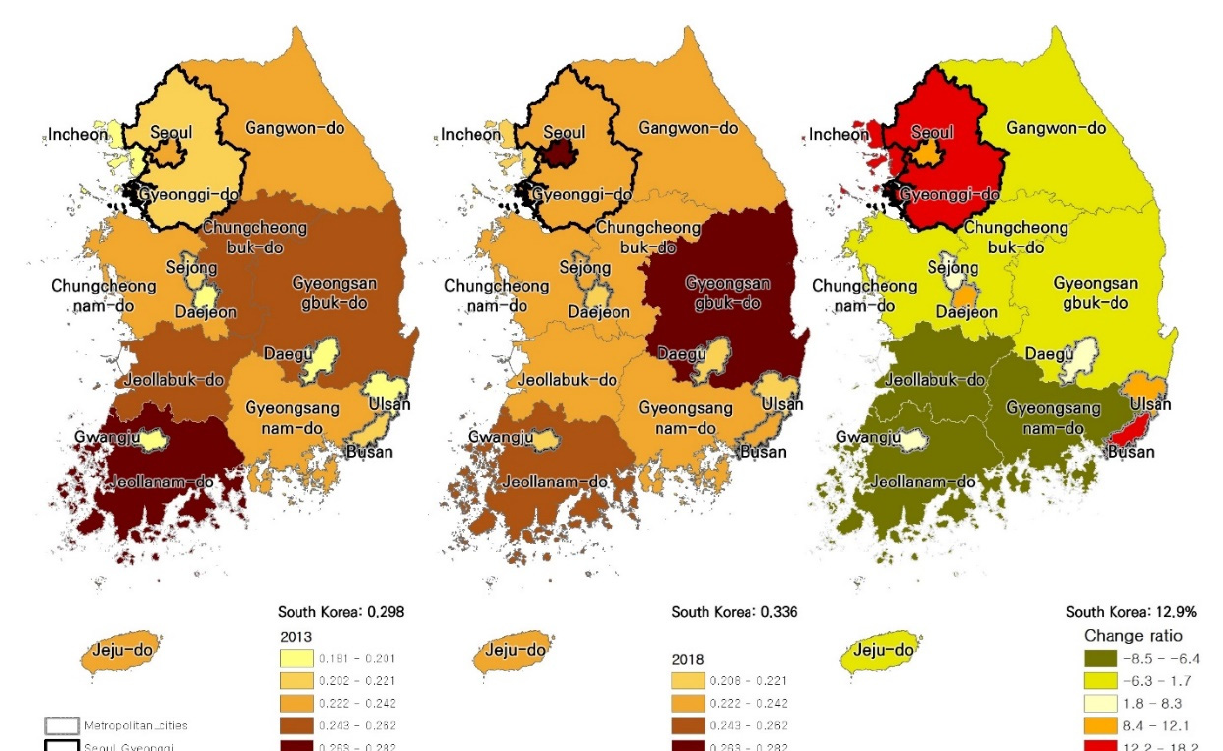
Figure 2. Housing Price Inequality Index and change rate in South Korea for 2013/2018. (a) Housing Price Inequality Index for 2013 (b) Housing Price Inequality Index for 2018 (c) Housing Price Inequality Index change rate between 2013 and 2018.